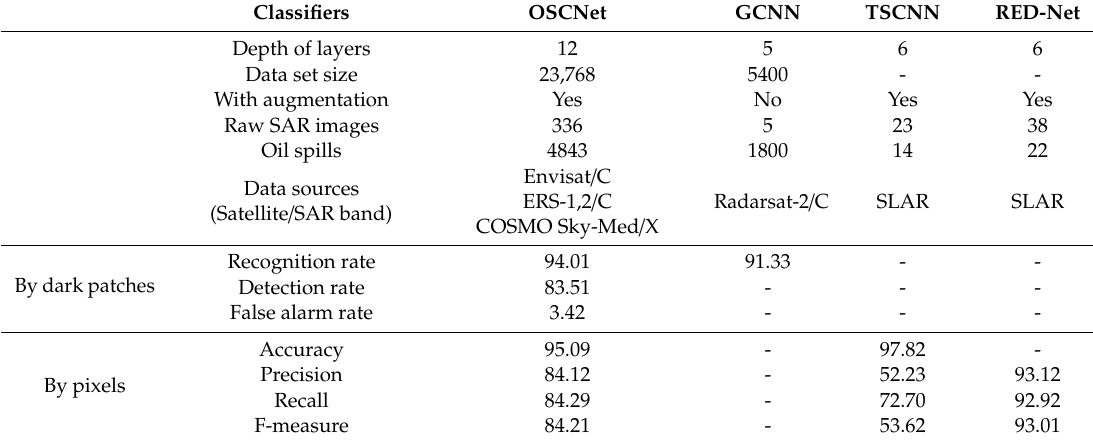
Table 15. Comparison of OSCNet and existing related